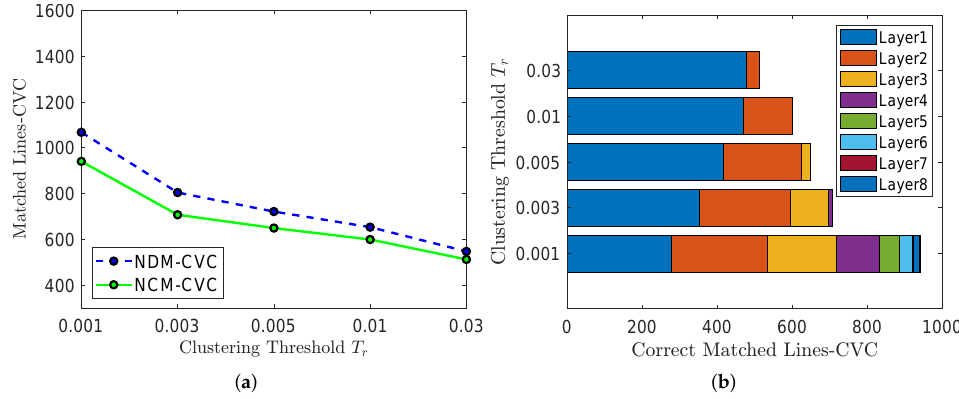
Figure 7. The influence of different T r on algorithm performance on the CVC dataset. ( a ) NDM, NCM of the CVC dataset, ( b ) layer distribution of the CVC